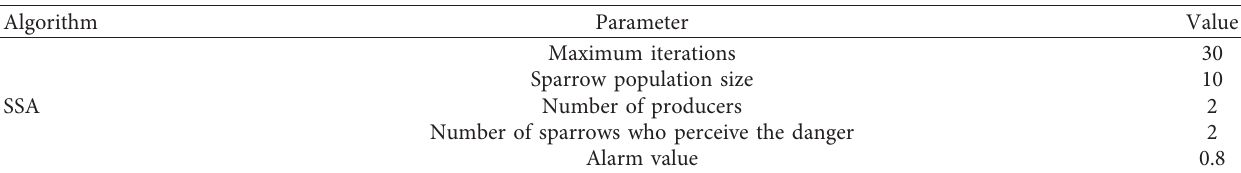
Figure 9: Visual scatter diagram of feature extraction. (a) The proposed method. (b) Traditional method. Table 4: Parameter setting of